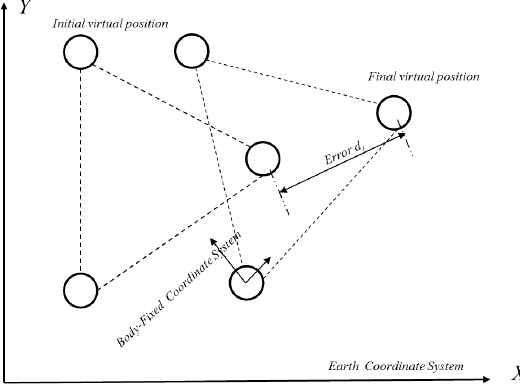
Figure 7. Schematic of the Virtual Structure (VS) approach for a three robot